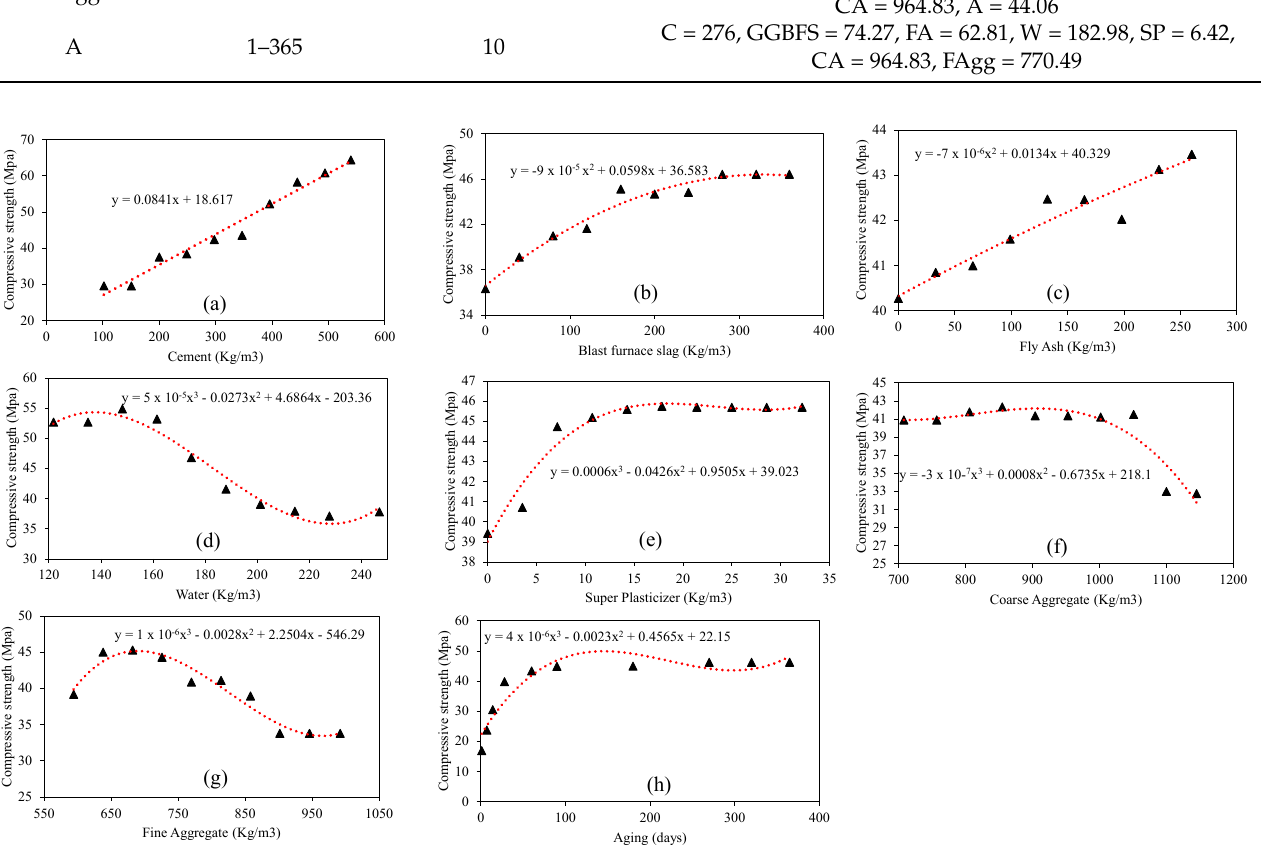
Figure 13. Parametric analysis of the GBT model i.e. variation of compressive strength with. ( a ) Cement ( b ) Blast furnace slag ( c ) Fly Ash ( d ) water ( e ) superplasticizer ( f ) Coarse Aggregates ( g ) Fina Aggregates ( h ) Age of testing.